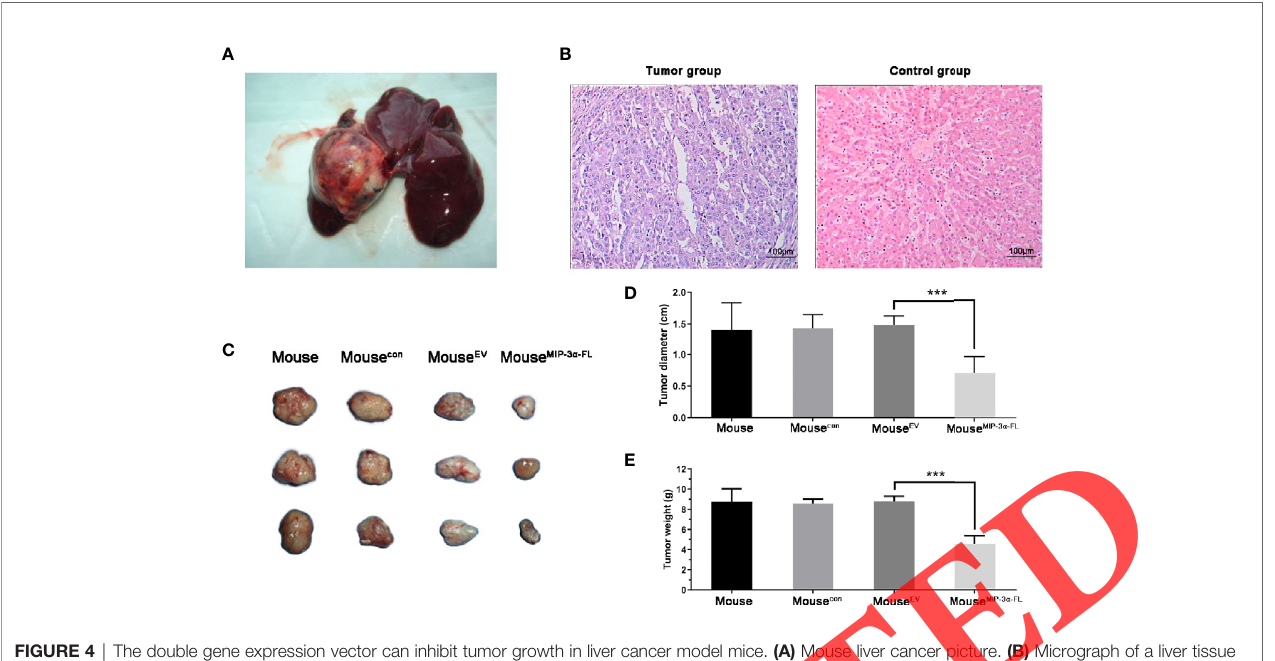
FIGURE 4 | The double gene expression vector can inhibit tumor growth in liver cancer model mice. (A) Mouse liver cancer picture. (B) Micrograph of a liver tissue section stained with H&E: liver tissue of the control group (left) and liver cancer tissue of the mouse model group (right) (H&E staining, magni fi cation × 100). (C) Tumor images of the different groups of tumor models. (D) The results of tumor volume measurement in tumor-bearing mice. (E) The results of tumor weight measurement in tumor-bearing mice compared with the Mouse MIP-3 a -FL group. *** P